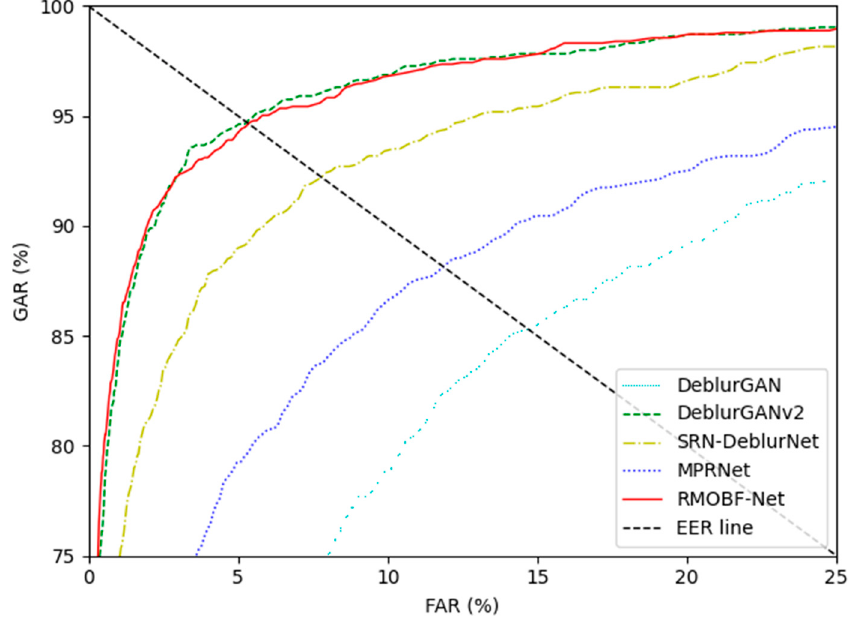
Figure 33. ROC curves of finger-vein recognition with PolyU-DB for scheme 5 by various restoration methods (random motion blur and optical blur with intensity 11 × 11 (Gaussian filter size) and 11 (Gaussian filter standard deviation)).